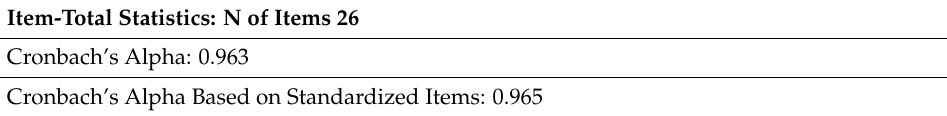
Table 5. Reliability